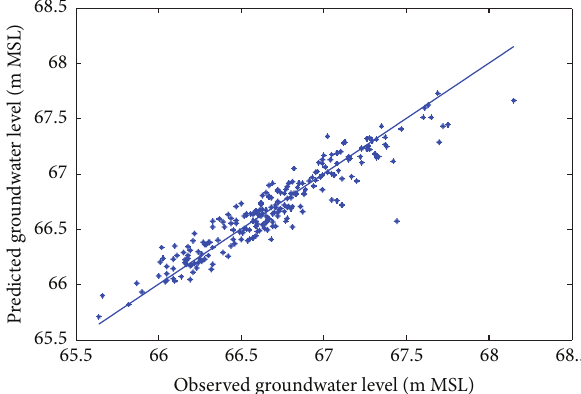
Figure 7: Comparison of observed groundwater levels with sim- ulated results for 1 month ahead using an ANN trained with the Levenberg–Marquardt algorithm (Lp 927).